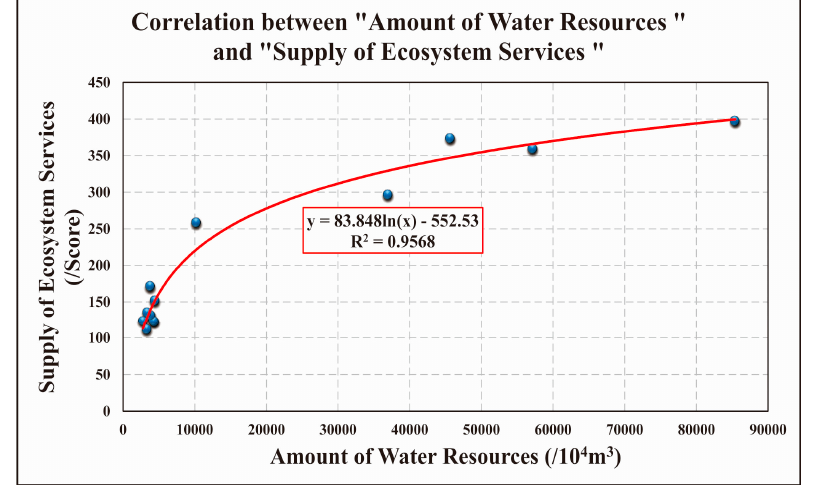
Figure 8. Correlation between “Amount of Water Resources” and “Supply of Ecosystem Services”.